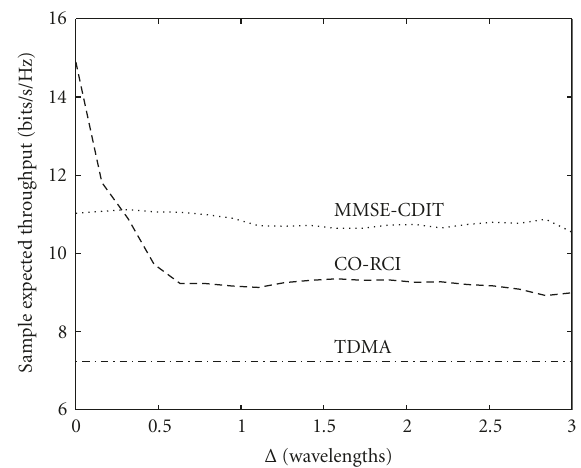
Figure 5: Sample expected throughput versus displacement for N t = N r = 4 antennas, K = 5 users, and P = 10 in Jakes’ model with exponential spatial correlation and various transmit precoding schemes.